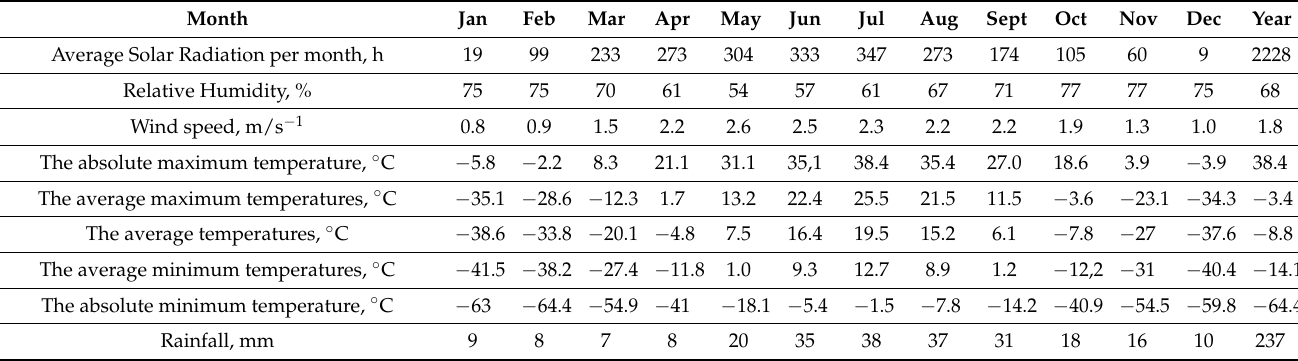
Figure 2. Exposure of BFRP rebar in Yakutsk: ( a ) in summer and ( b ) winter. Table 2 shows the climatic characteristics of the Yakutsk city. Table 2. The climatic characteristics of